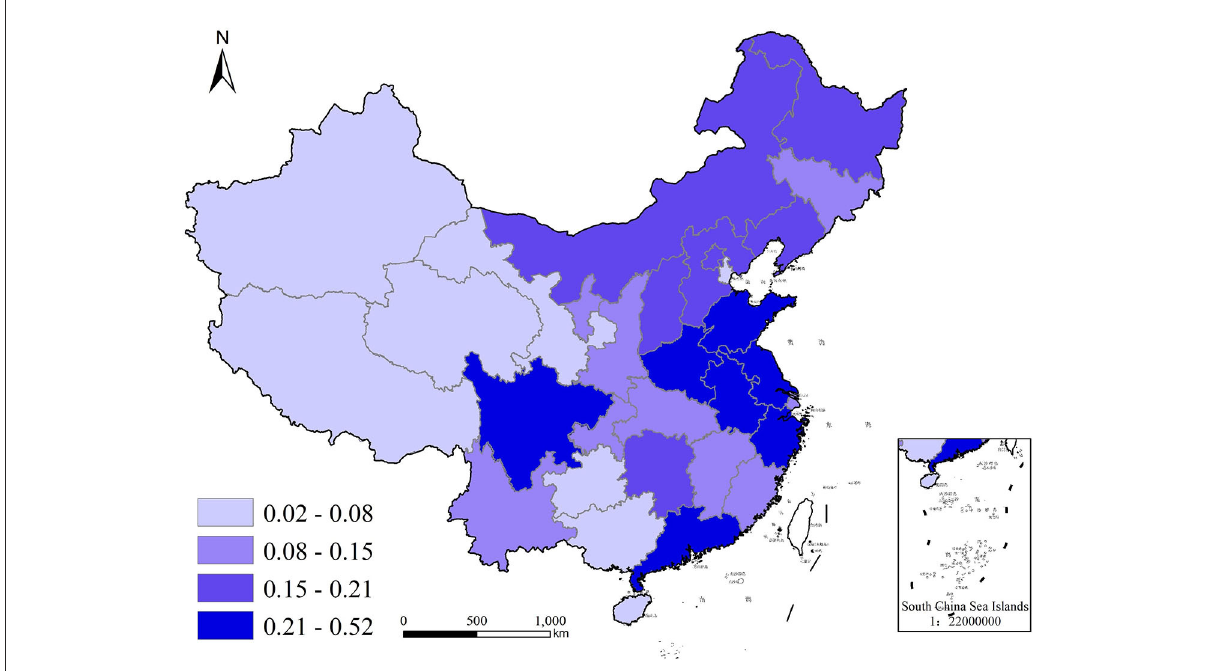
FIGURE4 Public health education in China in 2009.